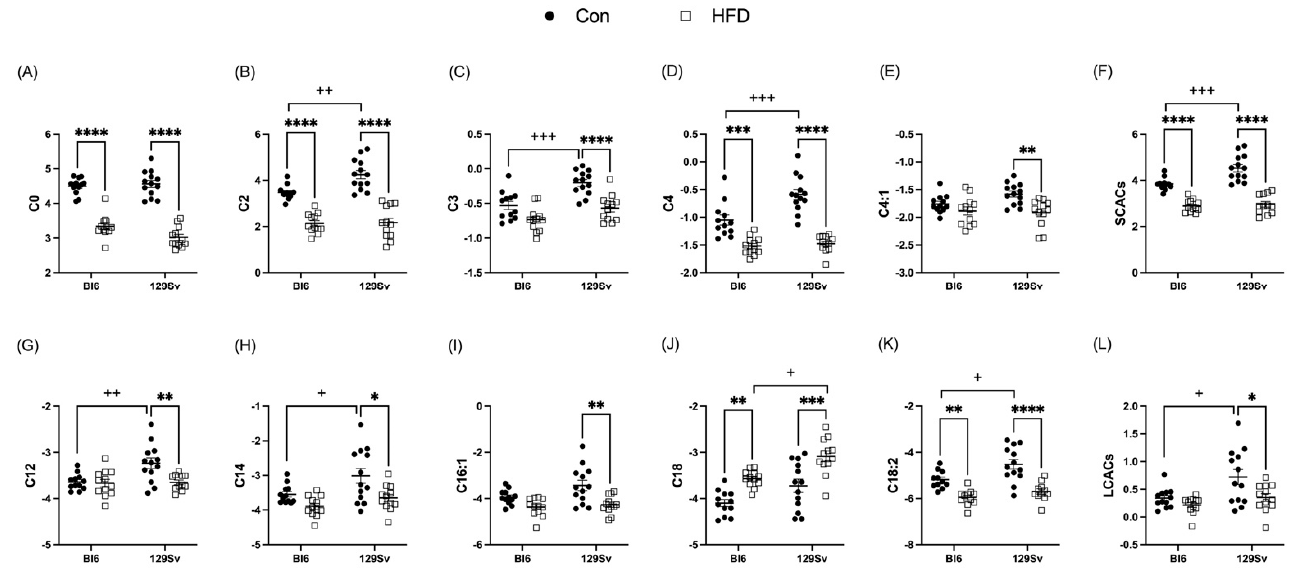
Figure 4. Effect of HFD on the level of selected acylcarnitines (Log2 values, data expressed as mean ± SEM). The level of short-chain acylcarnitines ( A ) C0, ( B ) C2, ( C ) C3, ( D ) C4-, and ( E ) C4:1 and ( F ) the sum of SCACs. The level of long-chain acylcarnitines ( G ) C12, ( H ) C14, ( I ) C16:1, ( J ) C18, and ( K ) C18:2 and ( L ) the sum of LCACs. Two-way ANOVA (Bonferroni post hoc test): * p ≤ 0.05, ** p ≤ 0.01, *** p ≤ 0.001, **** p ≤ 0.0001 (diet effect), + p ≤ 0.05, ++ p ≤ 0.01, +++ p ≤ 0.001 (strain effect).